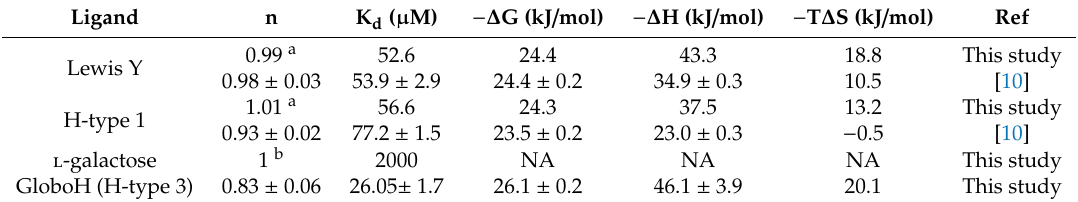
Table 1. A ffi nity measurements for the binding of various carbohydrates to rBC2L-CN2 by isothermal microcalorimetry at 25 ◦